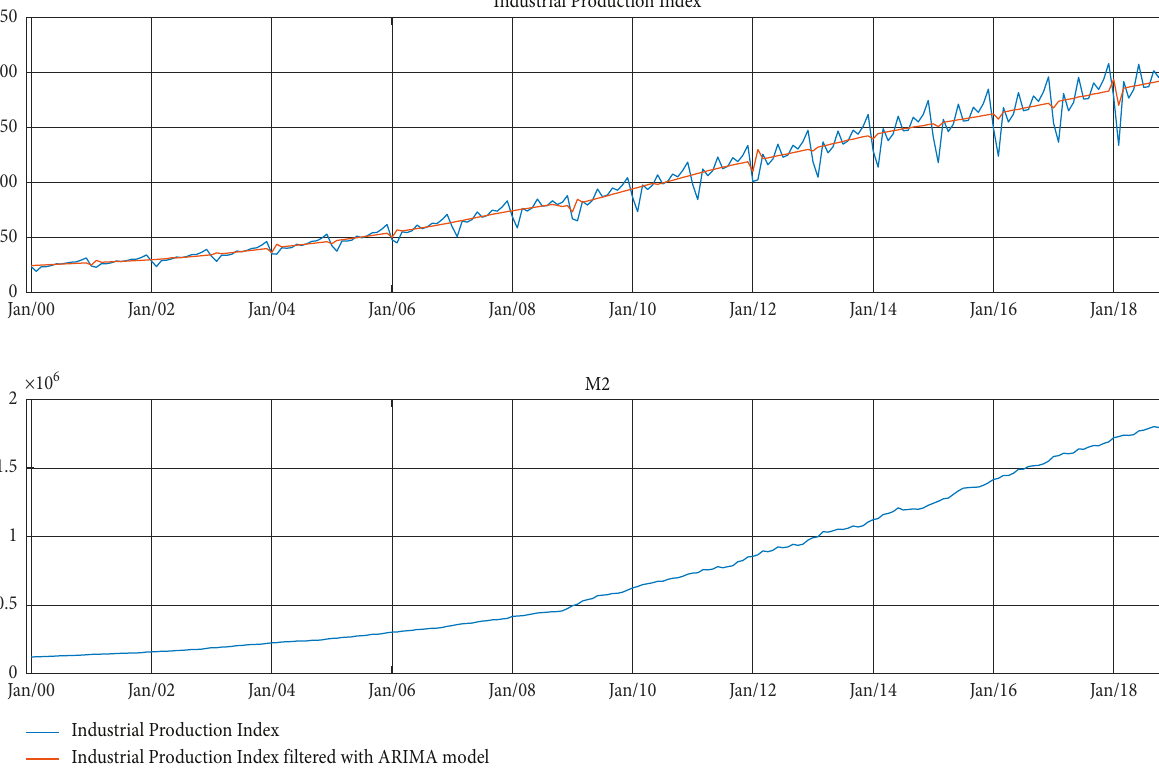
Figure 3: Industrial production index and